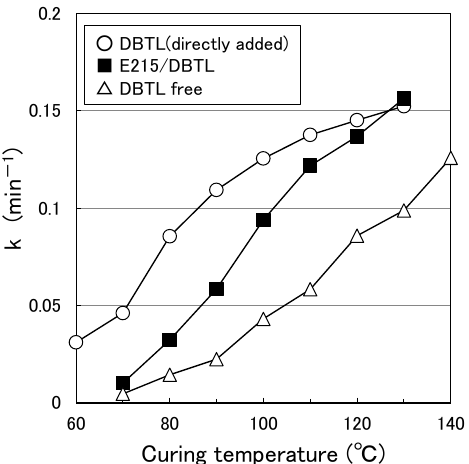
Figure 4. Relationship between k and curing temperature (surfactant: E-215).